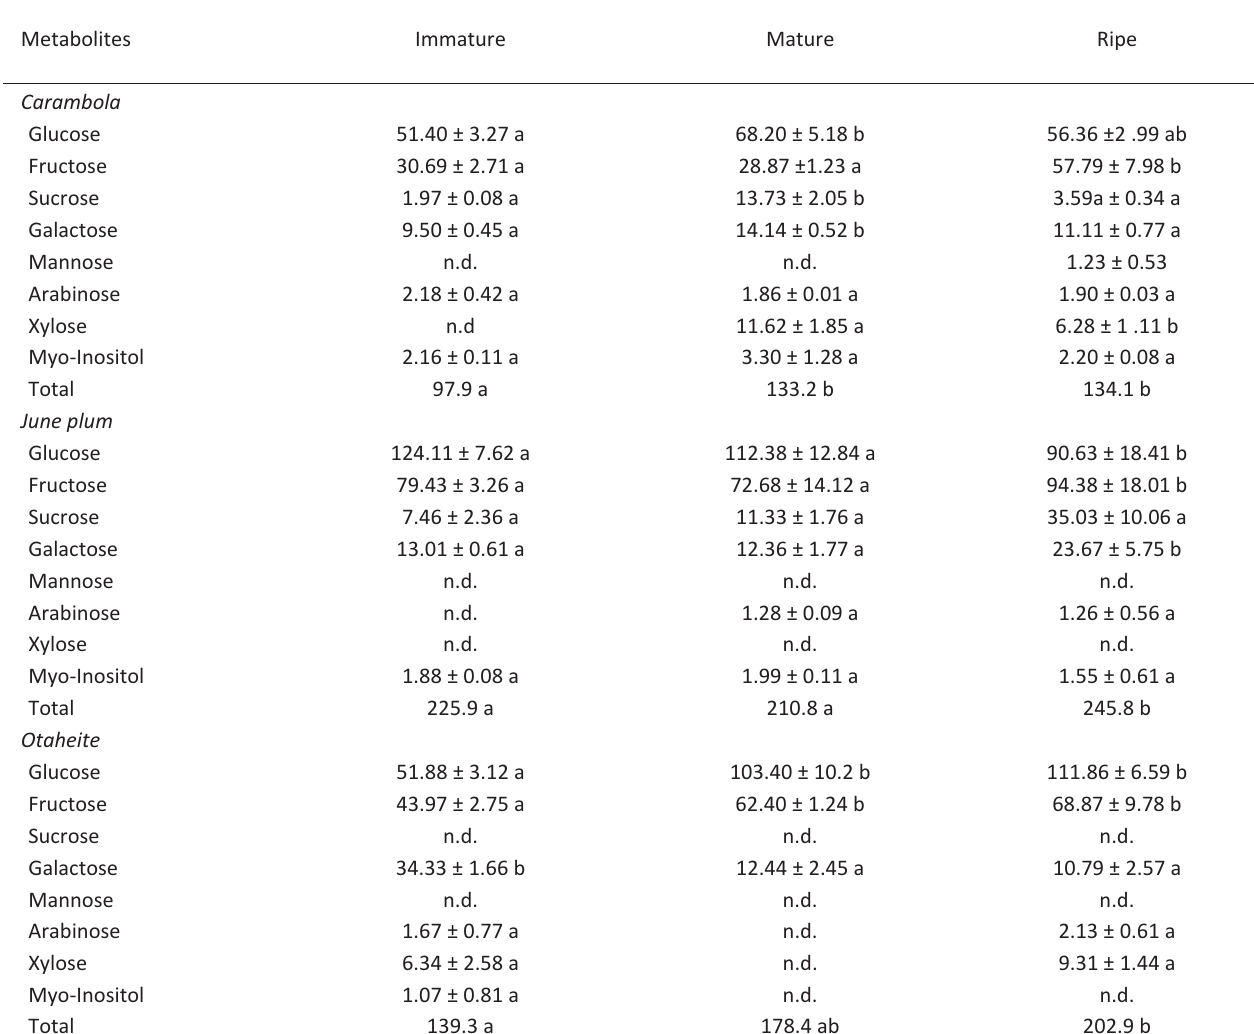
Table 1 ­ Profiled sugars and sugar alcohols and their contents (mg/g dry weight) in carambola, June plum and Otaheite during the three development and ripening stages